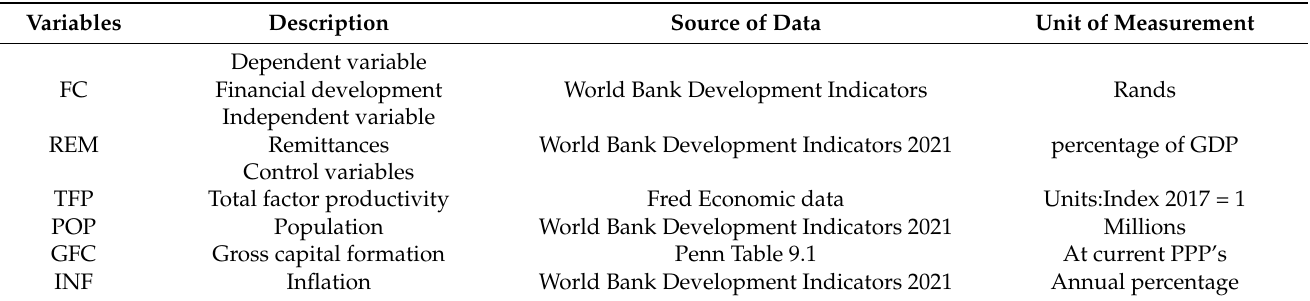
Table 1. Variables used in the